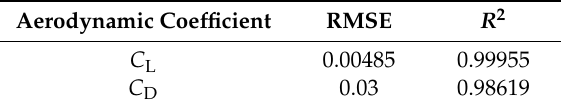
Table 2. Evaluation of the approximation model.